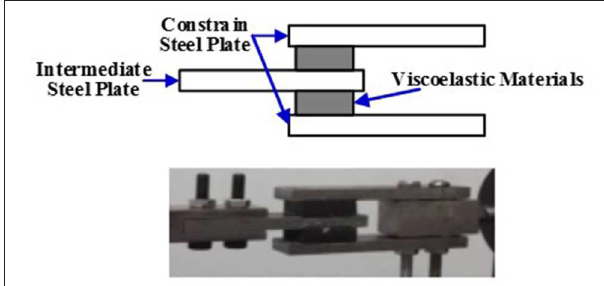
FIGURE 6 | The viscoelastic damper.